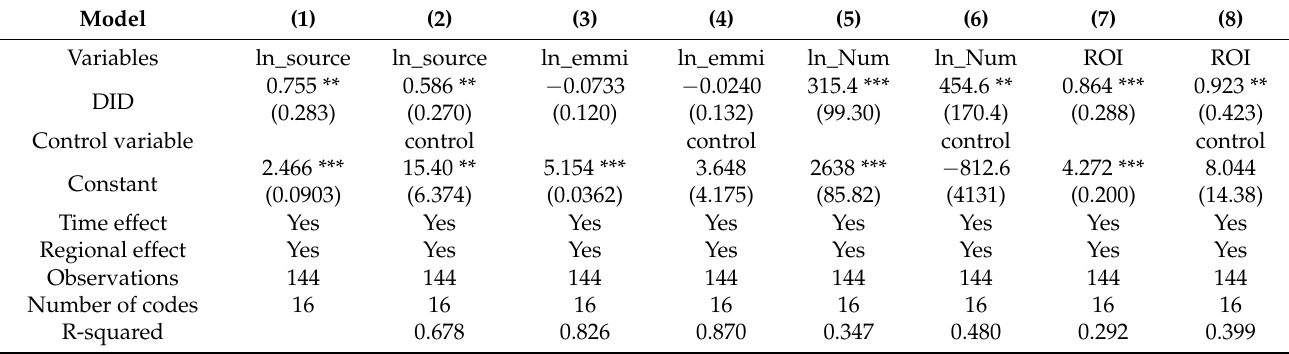
Table 3. Statistical table of regression results (1) 1